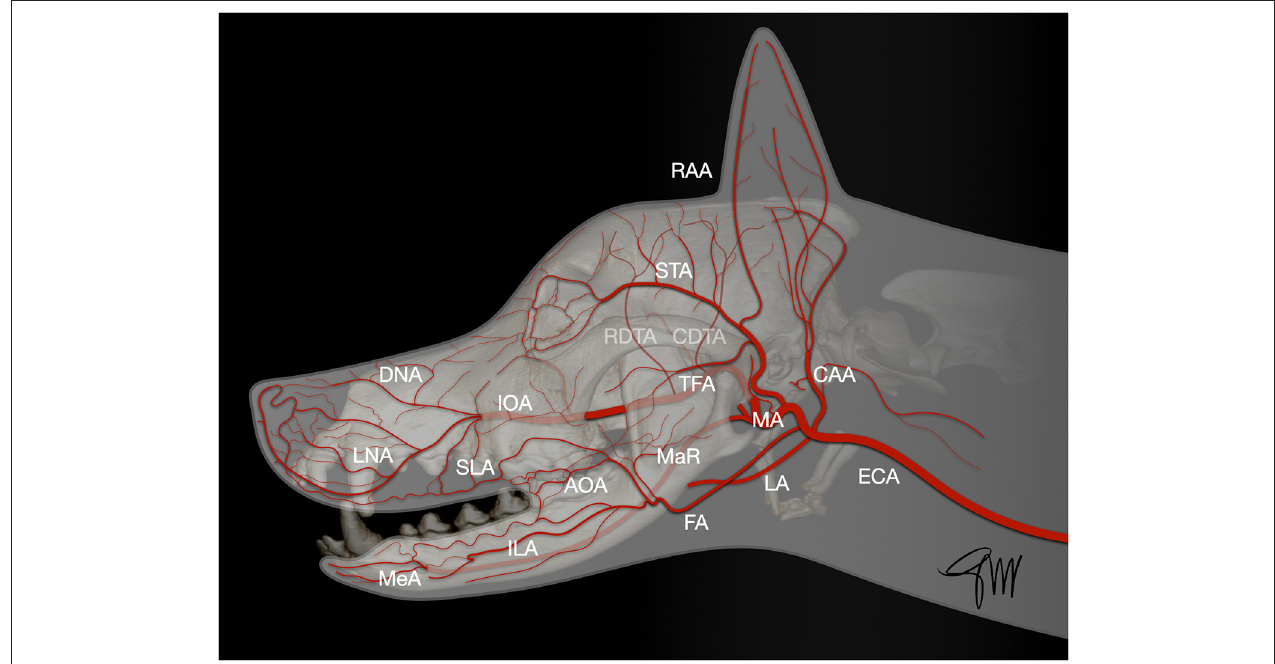
FIGURE 1 | Main arterial blood supply to the head in the dog. AOA, angularis oris artery; CAA, caudal auricular artery; CDTA, caudal deep temporal artery; DNA, rostral dorsal nasal artery; ECA, external carotid artery; FA, facial artery; ILA, inferior labial artery; IOA, infraorbital artery; LA, lingual artery; LNA, lateral nasal